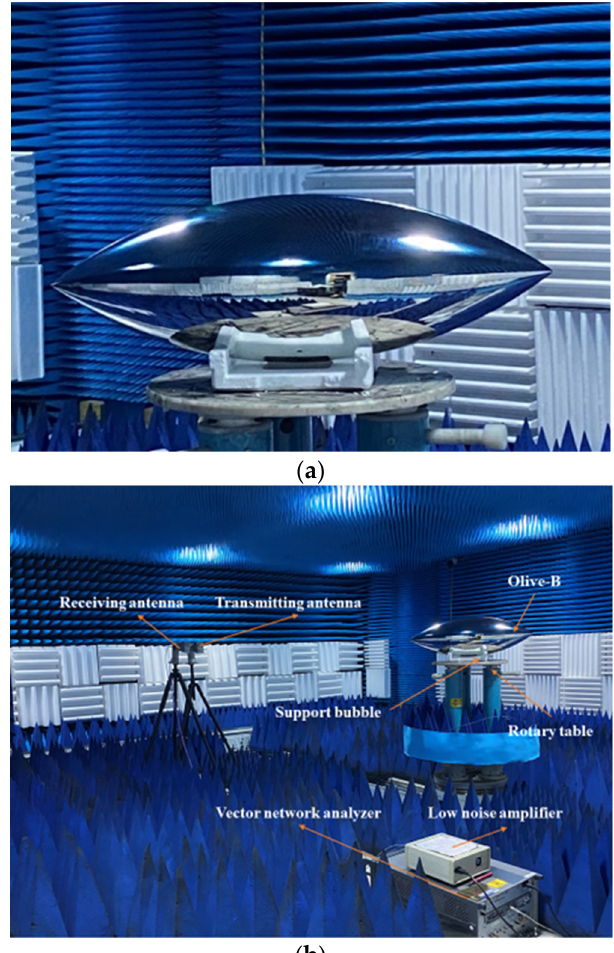
Figure 7. RCS test of the Olive-B satellite. ( a ) Metal model of the Olive-B. ( b ) Anechoic chamber.